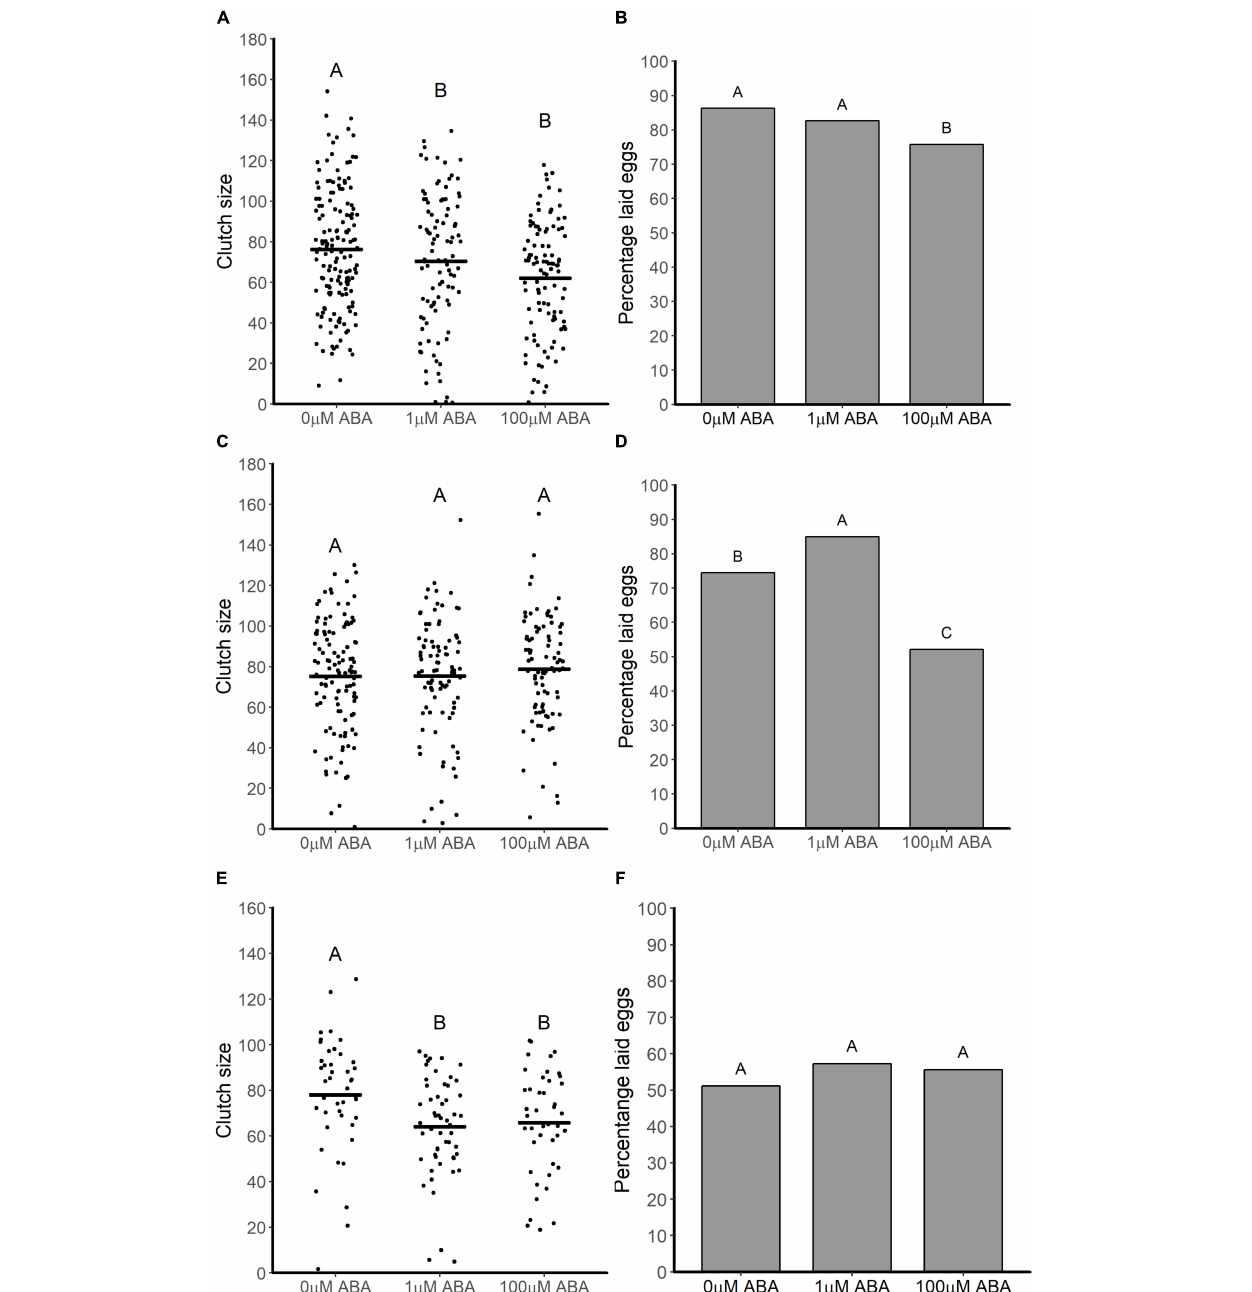
Frontiers in Microbiology |